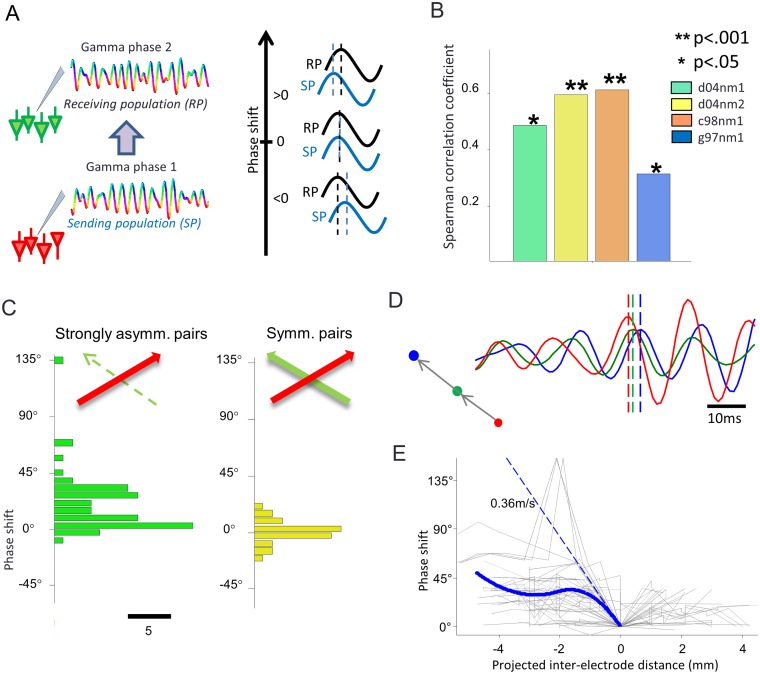
Spatial phase shifts.(A) Illustration of the meaning of the sign of the phase shift under our conventions. The ordering of the electrodes used to compute phase differences is illustrated on the left. At each time point, we compute the phase of the gamma-band-passed LFP in the receiving electrode, and we subtract it from the value of the phase of the gamma-band-passed LFP at the sending electrode. The cartoon on the right illustrates that positive (respectively negative) phase shifts indicate that the gamma oscillation at the sending side leads (respectively lags behind) the gamma oscillation at the receiving site. (B) Spearman’s correlation coefficient between the gamma phase shift and TE transferred between gamma phase at the sending site and MUA at the receiving site, computed separately for each recording session. Stars denote significant values. (C) Mean phase shift histogram for two groups of electrode pairs: on the left for strongly asymmetric pairs (shift is measured in the leading direction of causation). On the right, the histogram for symmetric pairs is shown. (D) Example of simultaneously-recorded LFP traces in the gamma-band for three aligned recording sites. Each site is color-coded. As schematized by the arrows in the left hand side, both blue and green recording sites were receiving sites, forming a strongly asymmetric pair with the sending recording site in red. During this time period, the time courses of each electrode (each plotted with the color of the corresponding electrode) exhibit ordered phase shift whose sign is consistent with wave propagation from the sending site to the receiving ones (see location of maxima corresponding to the zero phase of each signal, indicated by colored vertical bars). (E) Phase shift against projected interelectrode distance along the direction of causation. Gray lines indicate plots for individual directions of dominant propagation in all sessions. Approximation by cubic spline regression of the pooled data is shown as a solid blue line. The dashed blue line is the tangent of this regression function at the origin. The slope of the tangent is indicated. Data available at http://dx.doi.org/10.6084/m9.figshare.1460872.